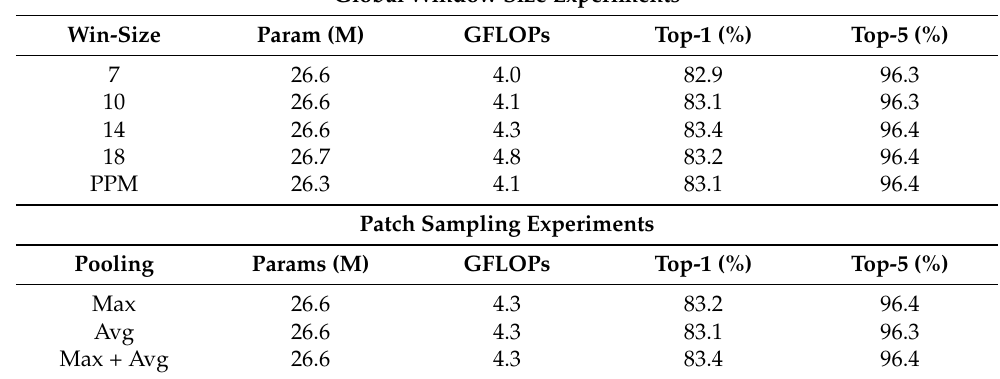
Table 6. Ablation study of global self-attention on ImageNet-1K [21]. In the first part, the influence of the global window size was determined. PPM refers to the pyramid-pooling module [60], which replaced our global self-attention in this case. In the second part, the impact of pooling on patch- sampling was